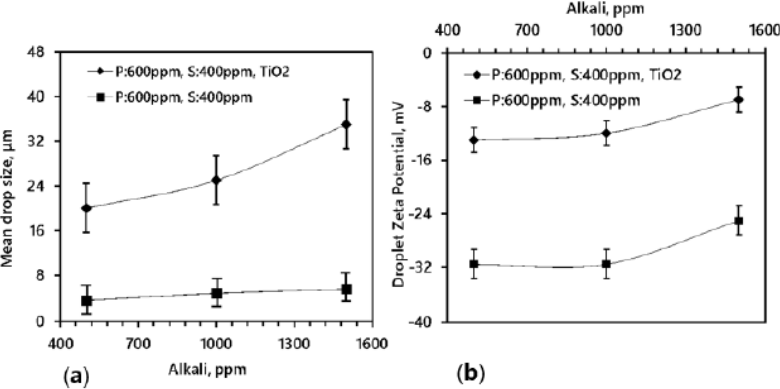
Figure 8. Droplet size and zeta potential before and after treatment with TiO 2 ( a ) Mean drop size of 5 and 35 µ m determined with a cross-polarized microscope at various ASP concentrations and 40% water cut with and without TiO 2 , respectively. ( b ) Droplets Zeta Potential (attraction force) at various ASP concentrations and 40% water cut with and without TiO 2